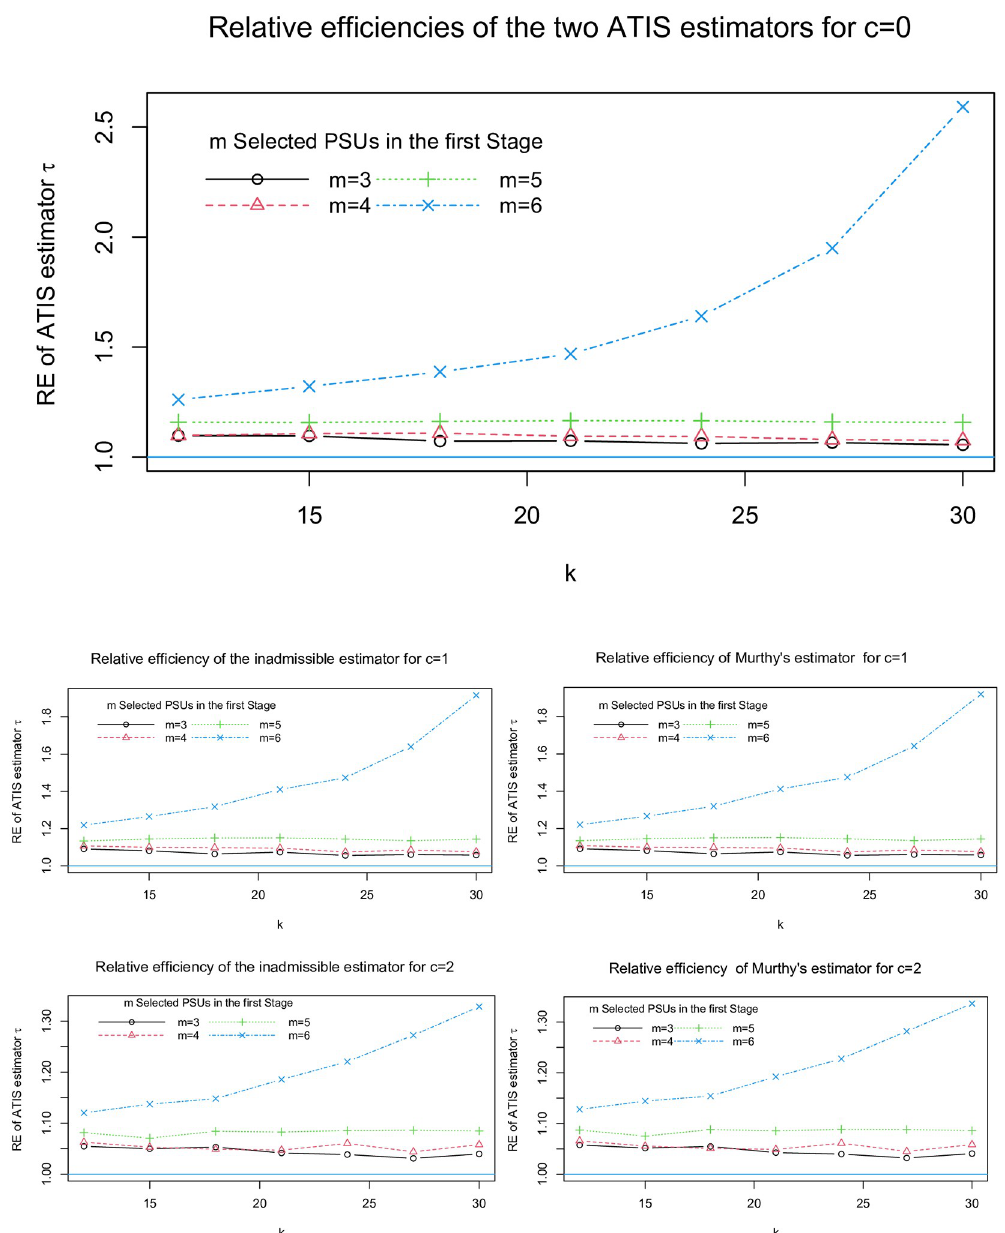
Fig 3. The buttercup population is partitioned into 6 PSUs of size 50 and the relative efficiency of Murthy’s and the inadmissable estimators of ATIS are computed for different values of m , k and c which are presented in 5